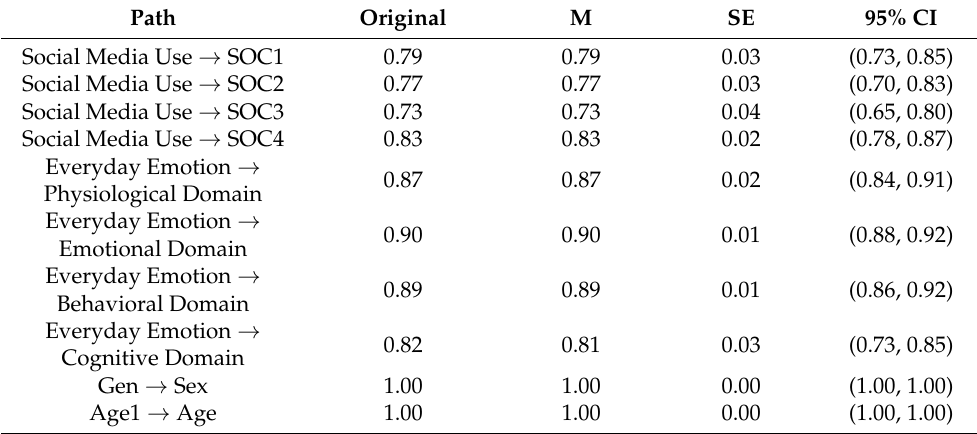
Table 8. Bootstrap results for the loadings of each indicator.